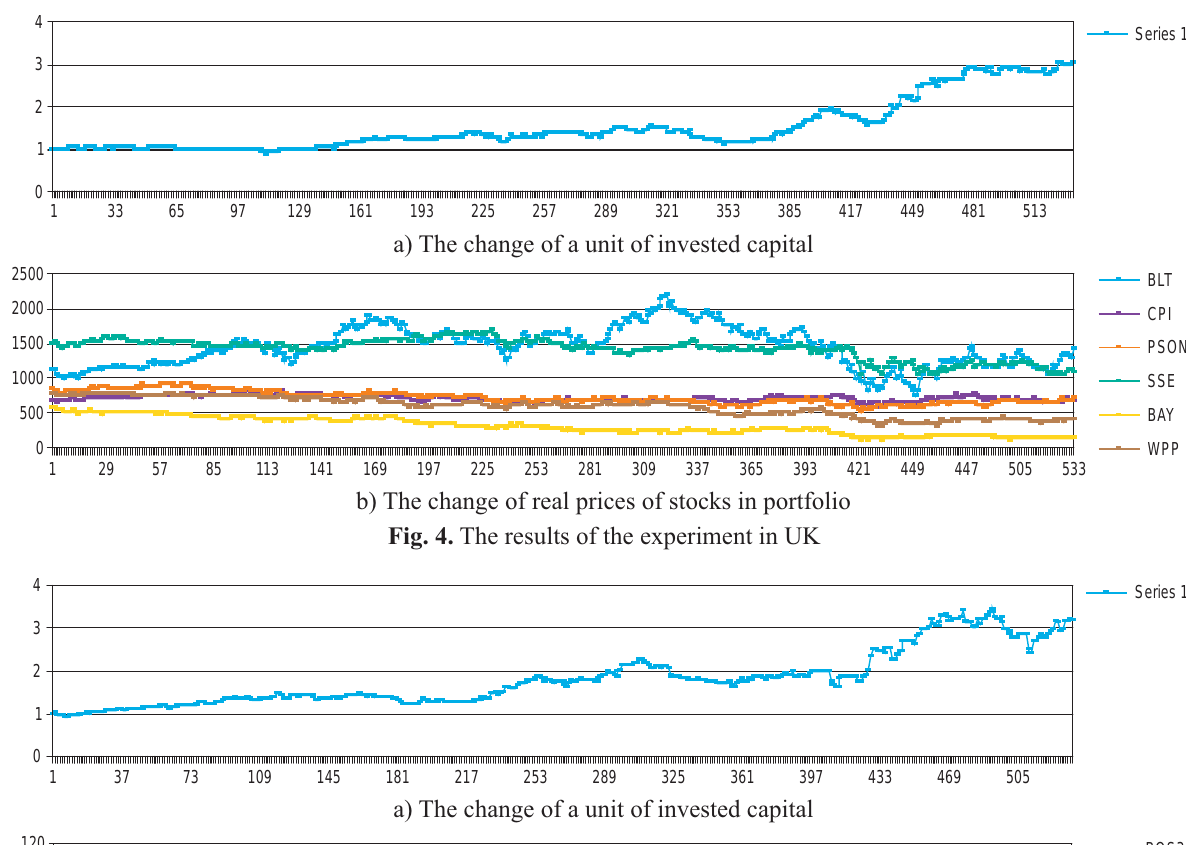
Fig. 4. The results of the experiment in UK